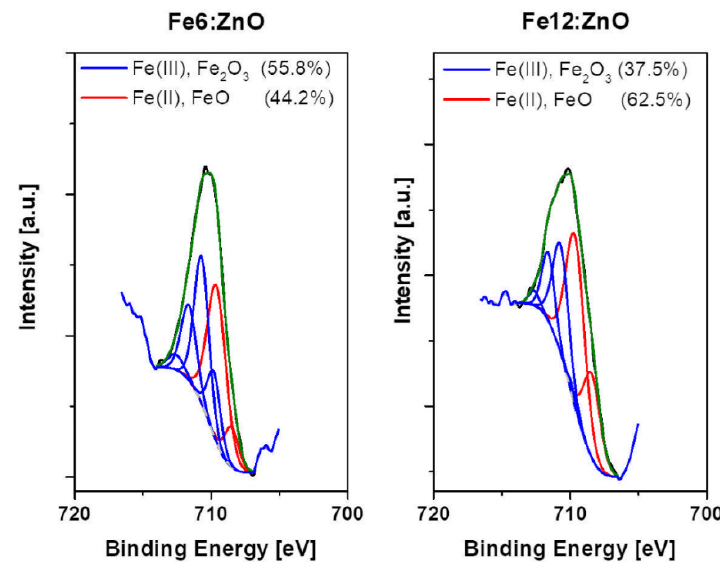
Figure 5. Curve-fitted Fe2p 3/2 spectrum for Fe:ZnO nanoparticles.